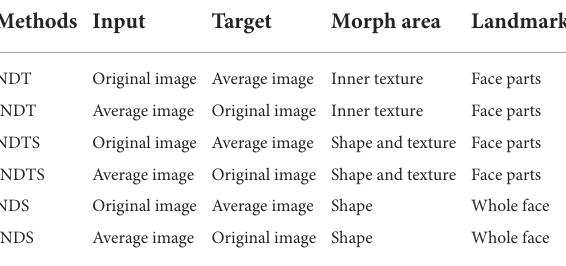
TABLE 1 The differences in face morphing